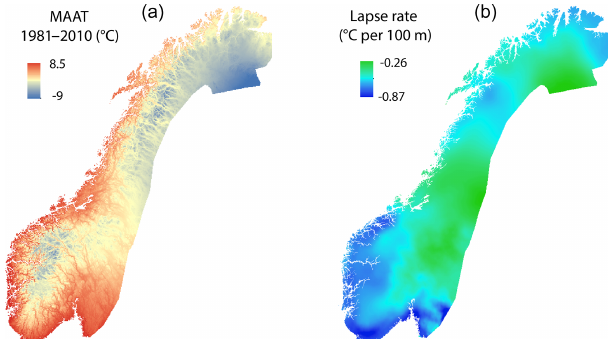
Figure 4. The 1km grid mean annual air temperature (MAAT) de- rived from the SeNorge2 dataset ( a , Lussana et al., 2017) and aver- aged lapse rate over a 25km radius (b)